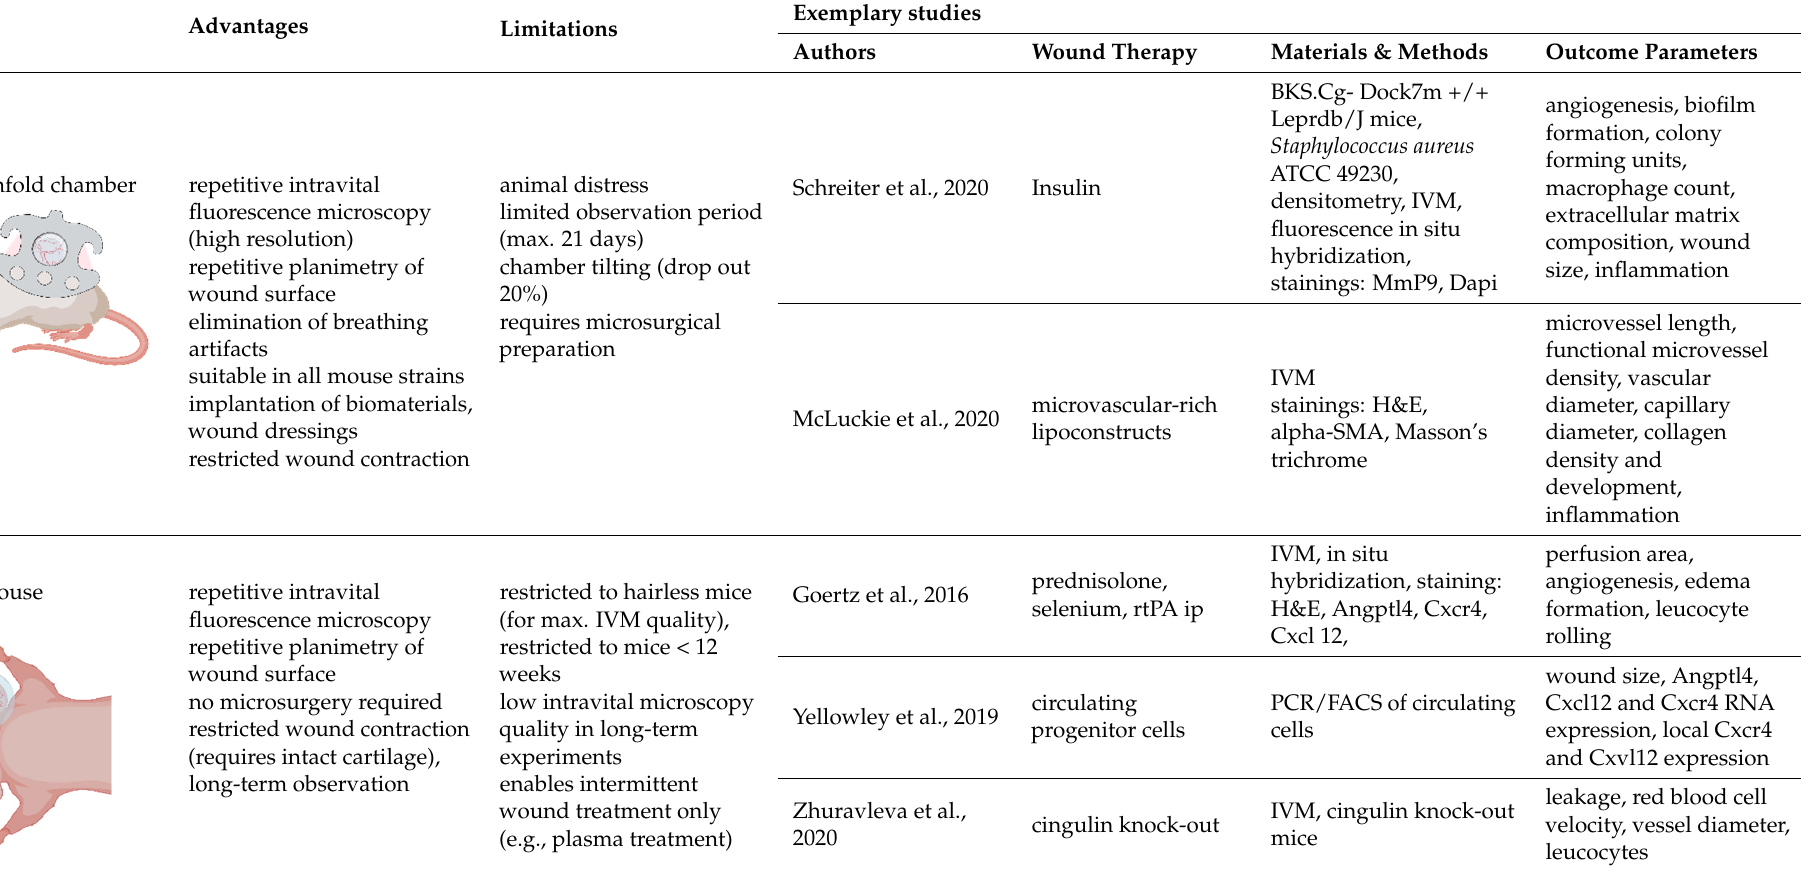
Table 2. Schematic illustration and overview on important advantages and limitations of established in vivo models for angiogenesis in wound healing.